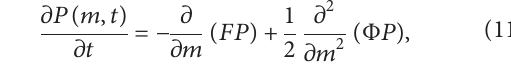
� 0 . 27 ) , ( c � 0 . 27 ) , ( c � 0 . 23 ) , 32 34 43